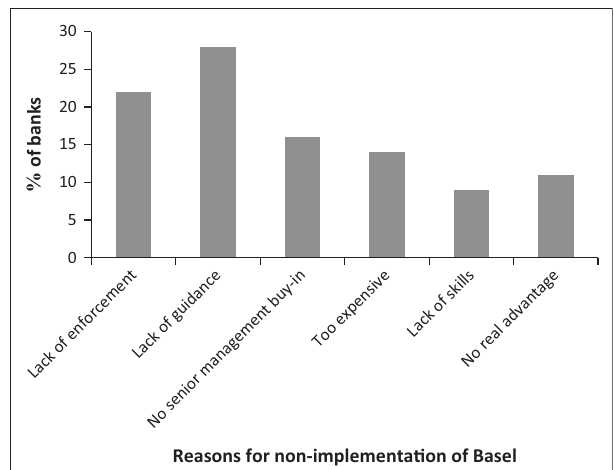
FIGURE 2: Reasons for the non-implementation of Basel II or Basel III.